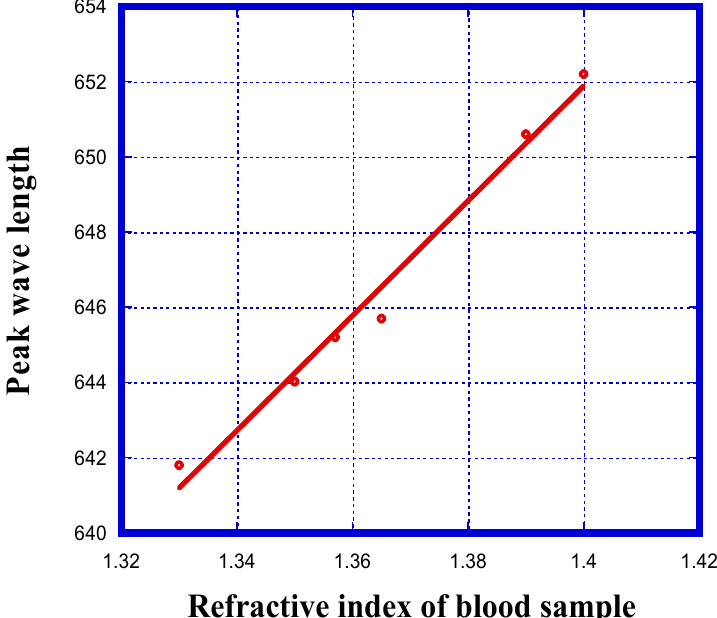
Figure 6. The central wavelength of the defect mode as a function of the refractive index of normal and infected blood samples containing different components.